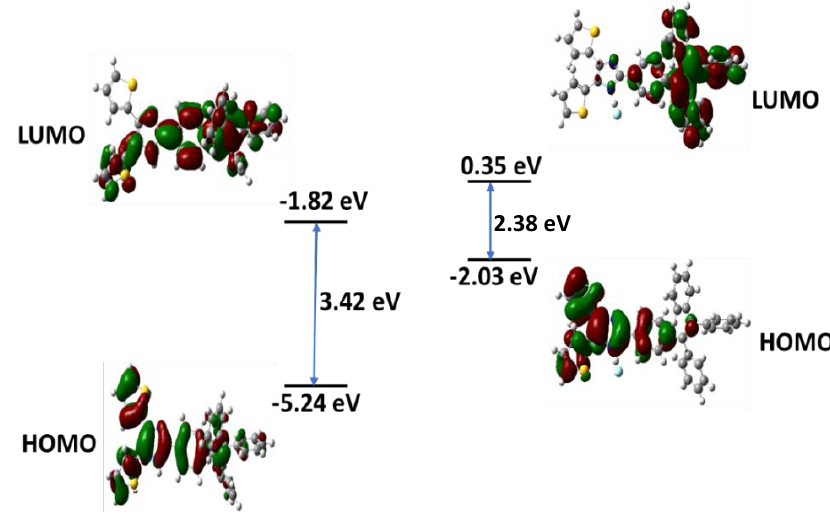
Figure 7. Energy levels diagram of DTITPE and DTITPE.F - calculated by DFT.